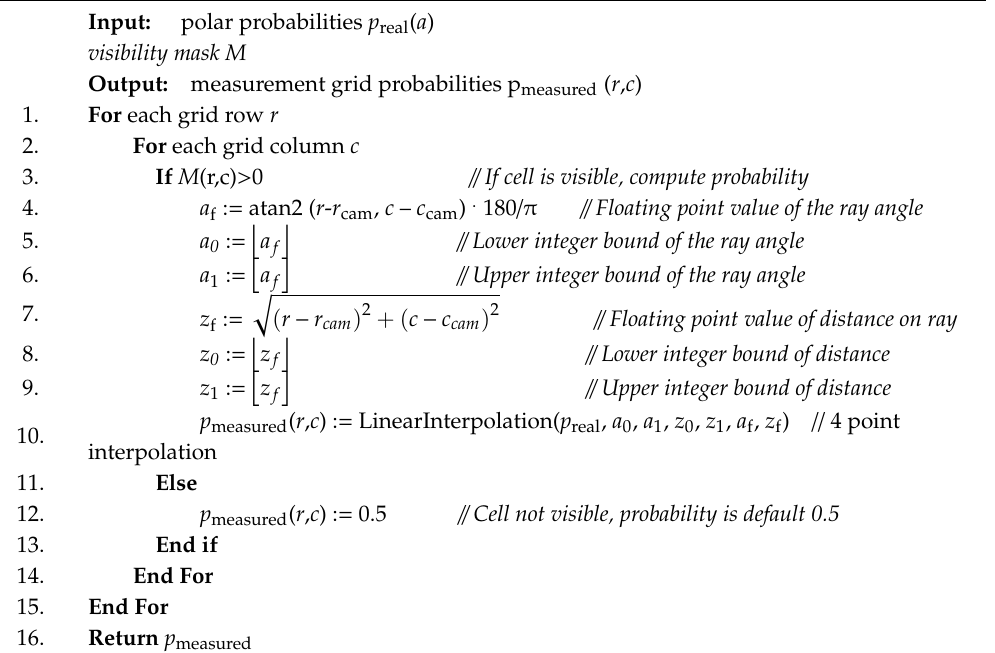
Algorithm 2 : Creation of the measurement probability grid